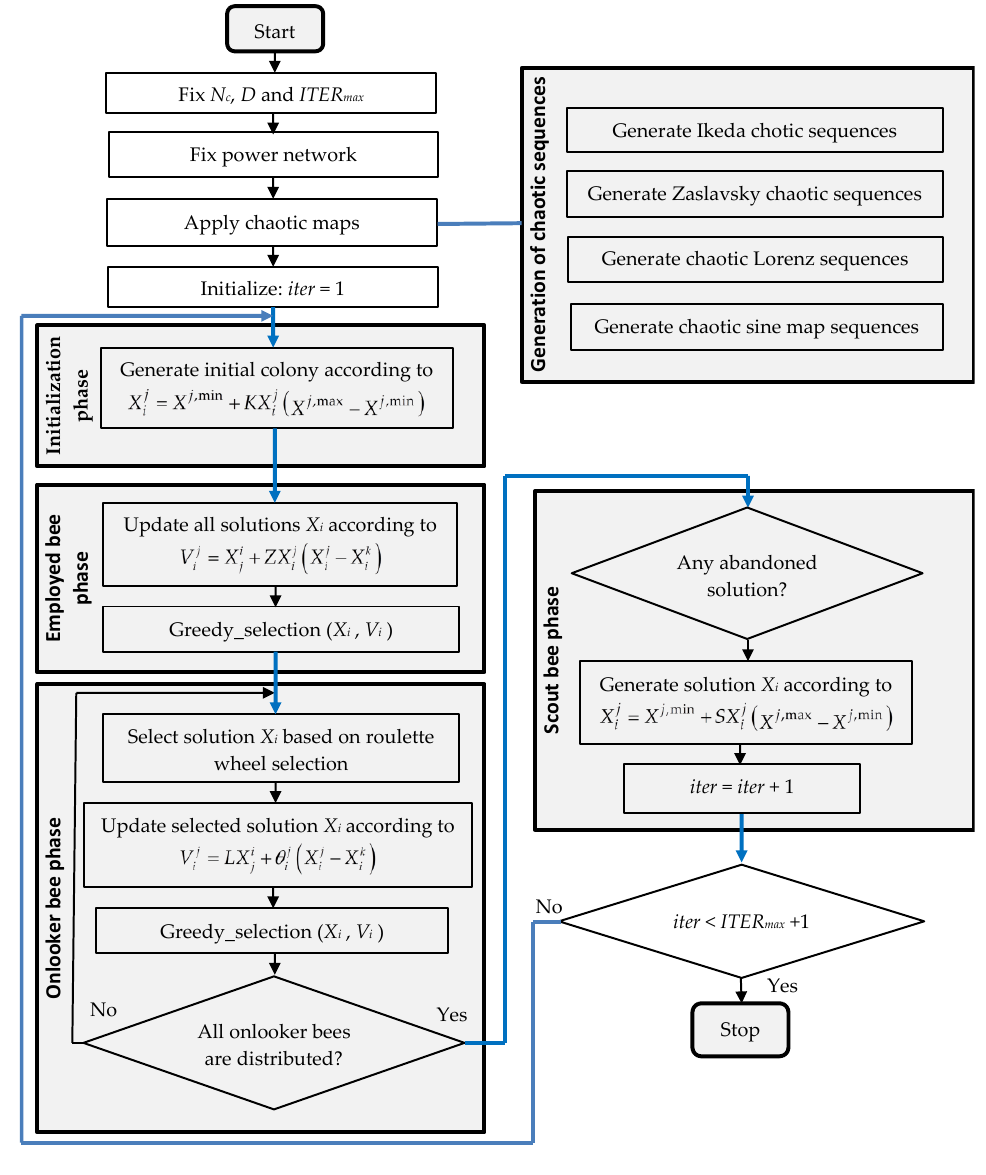
Figure 5. HCABC flowchart.